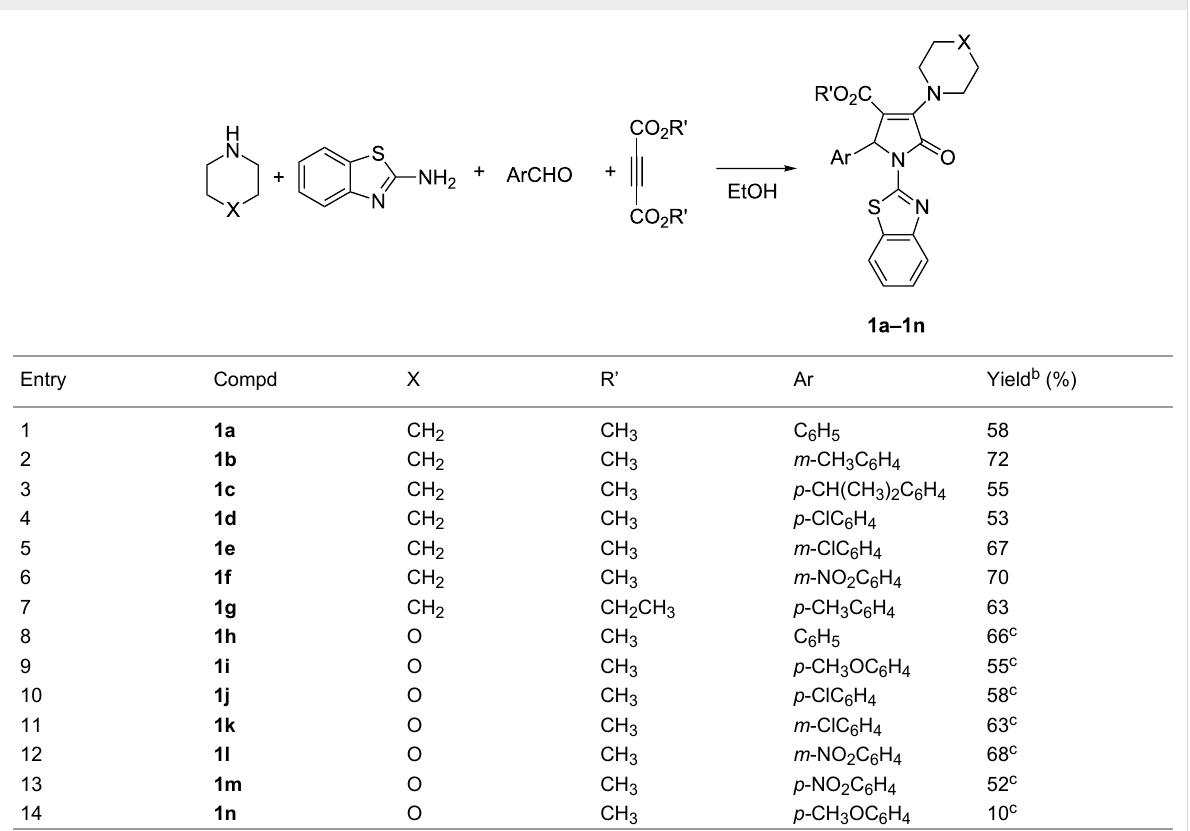
Table 1: Synthesis of pyrrolidinones 1a – 1n via four-component reactions a